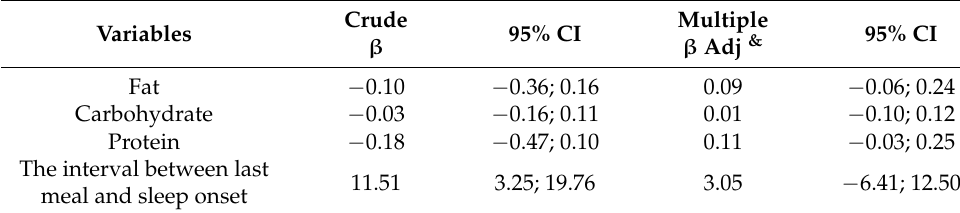
Table 2. Sleep onset latency (SOL) on day-off (nocturnal sleep) ( n = 22).